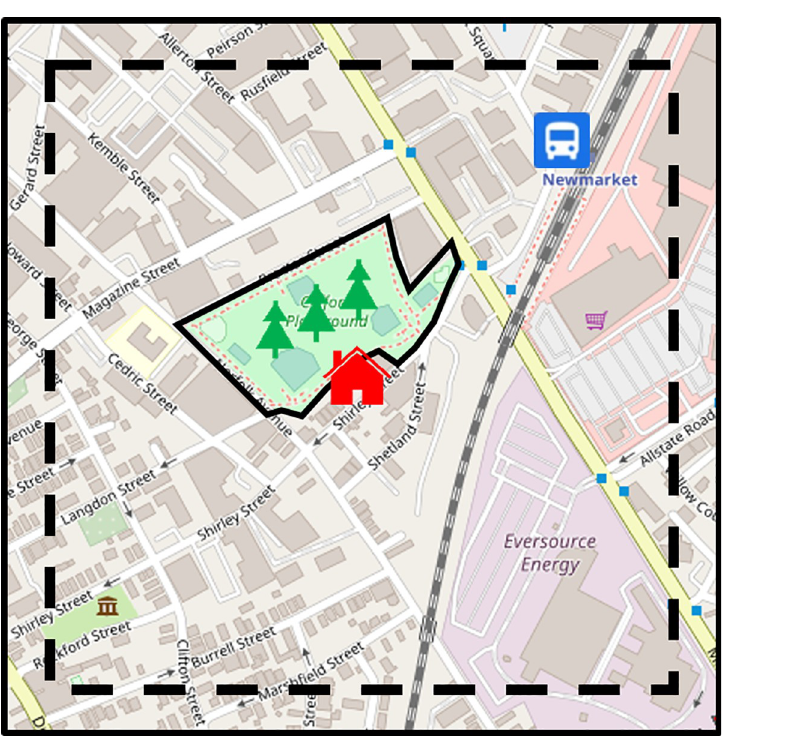
Fig 2. Schematic diagram of the definitions of park size and distance to